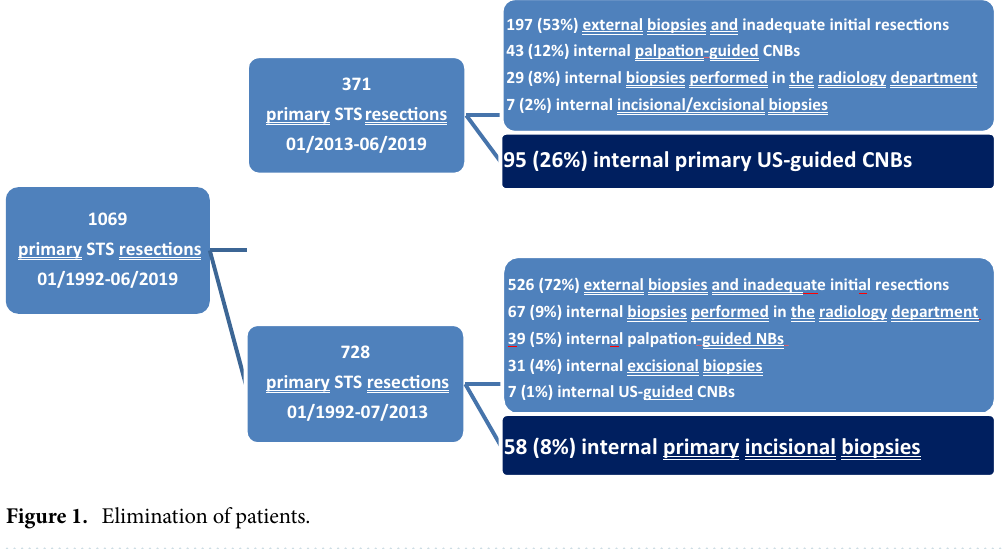
Figure 1. Elimination of